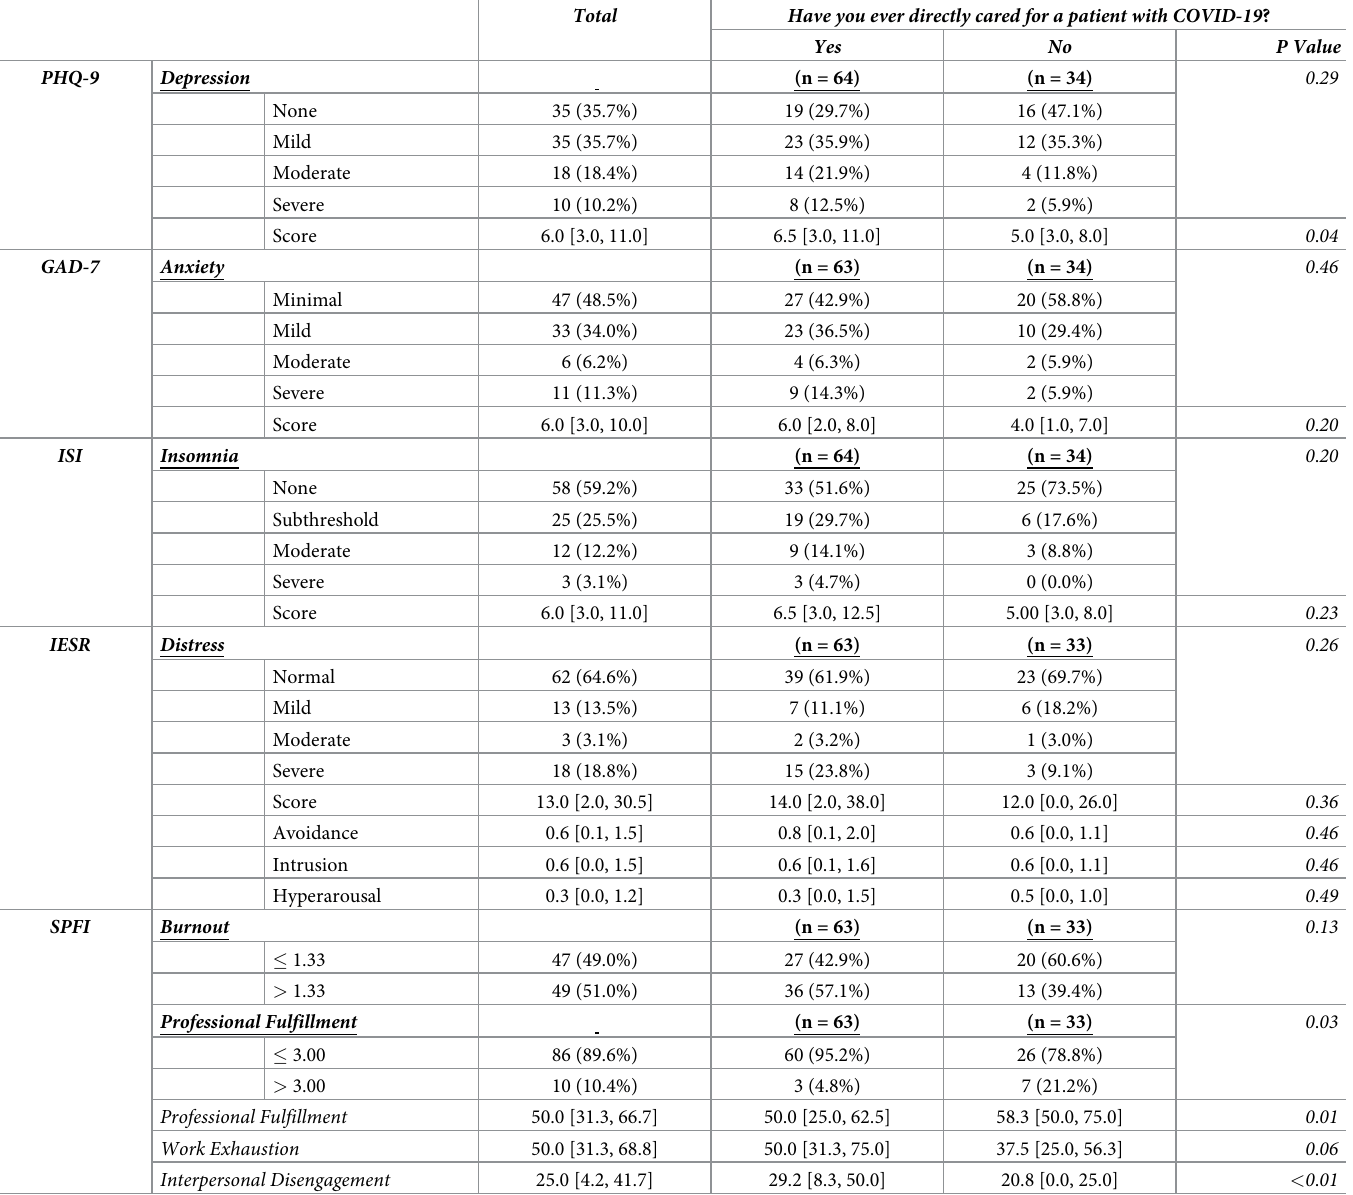
Table 2. Baseline characteristics of study participants (N =